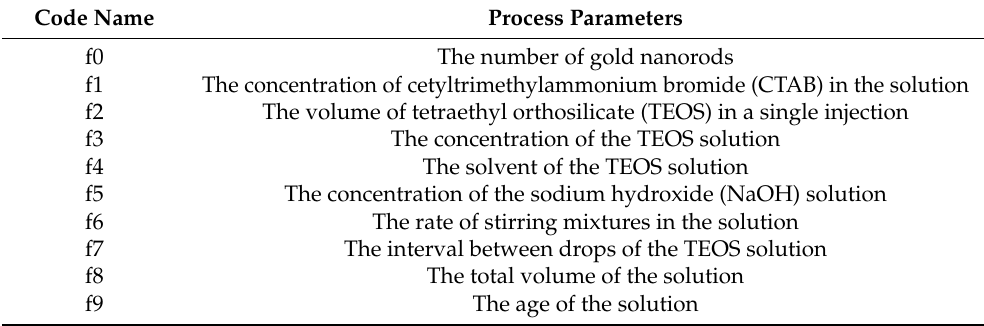
Table 1. The description of feature